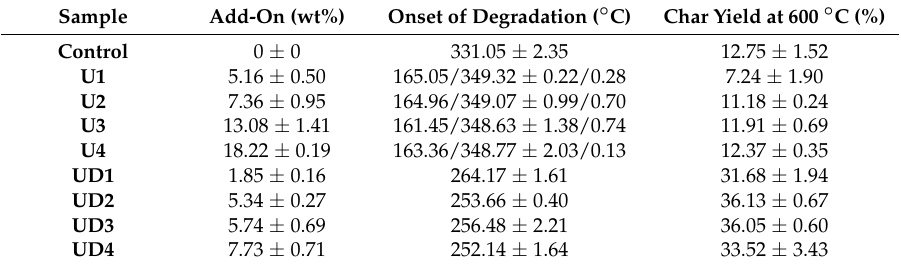
Figure 2. Degradation thermograms of treated samples of urea only ( a ) and urea/diammonium phosphate ( b ) at various add-ons (wt%) by TGA in nitrogen atmosphere. Table 2. Thermal degradation and char content determination of different add-ons (wt%) of urea only and urea/diammonium phosphate treated samples by TGA at 600 °C in nitrogen atmosphere. (Three observations for each sample).